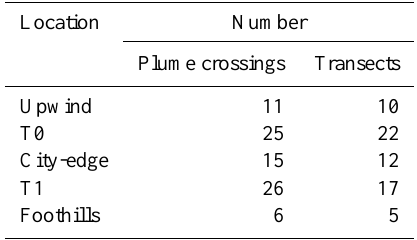
Table 2. Number of plume crossings and